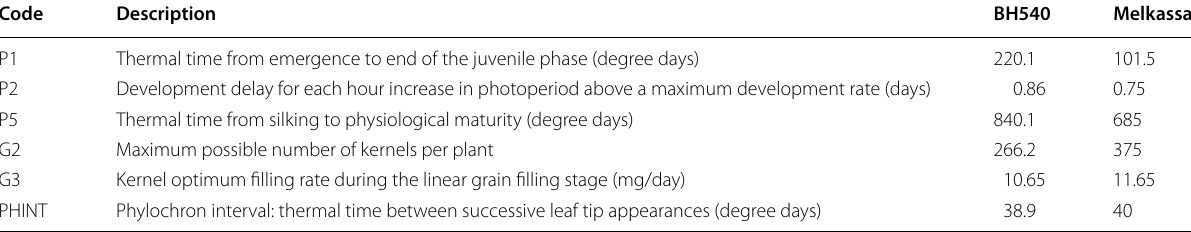
Table 3 Genetic coefficients for BH540 and Melkassa I maize cultivars (Kassie et al. 2014)